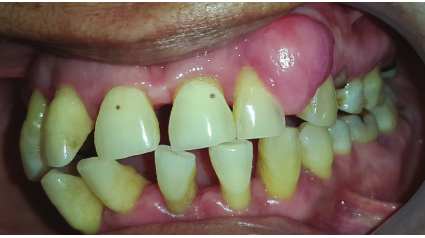
Figure 1: Preoperative facial view showing gingival overgrowth in upper left premolar region.